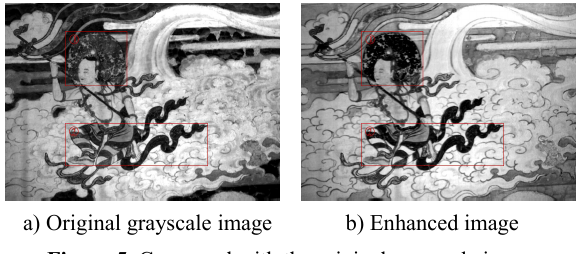
Figure 5 . Compared with the original grayscale image